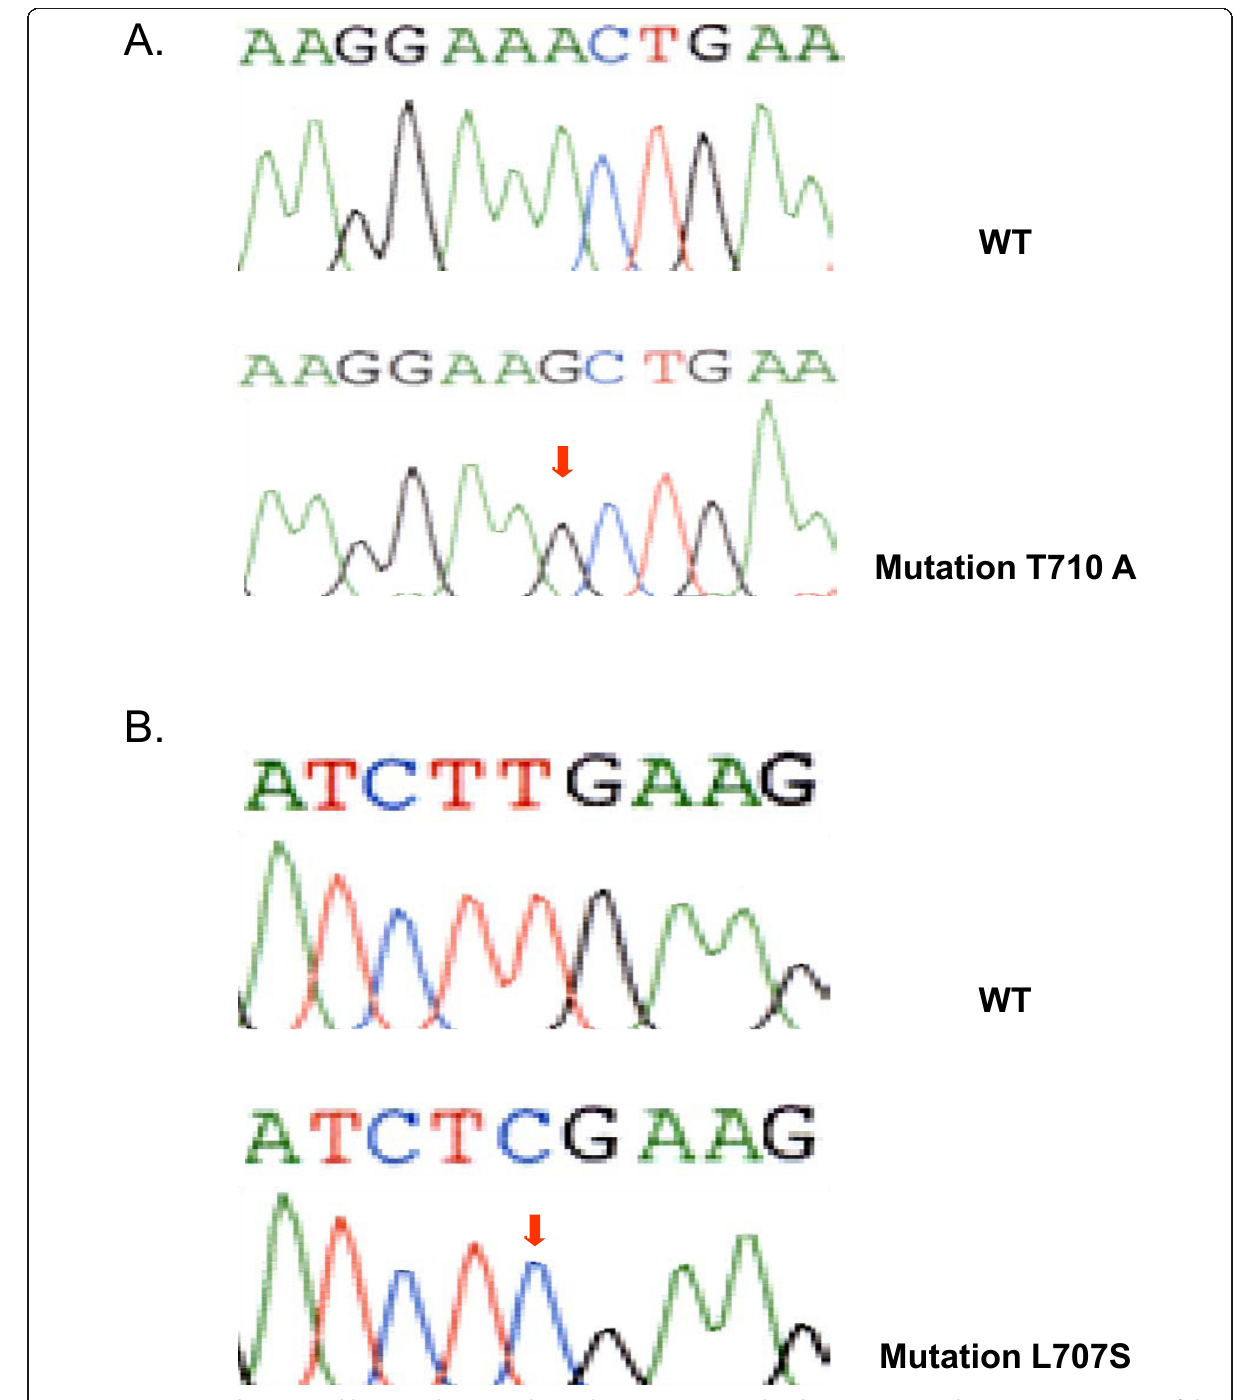
Figure 1 Comparison between wild type and mutant electropherograms in A and B showing two novel mutations in exon 18 of the EGFR